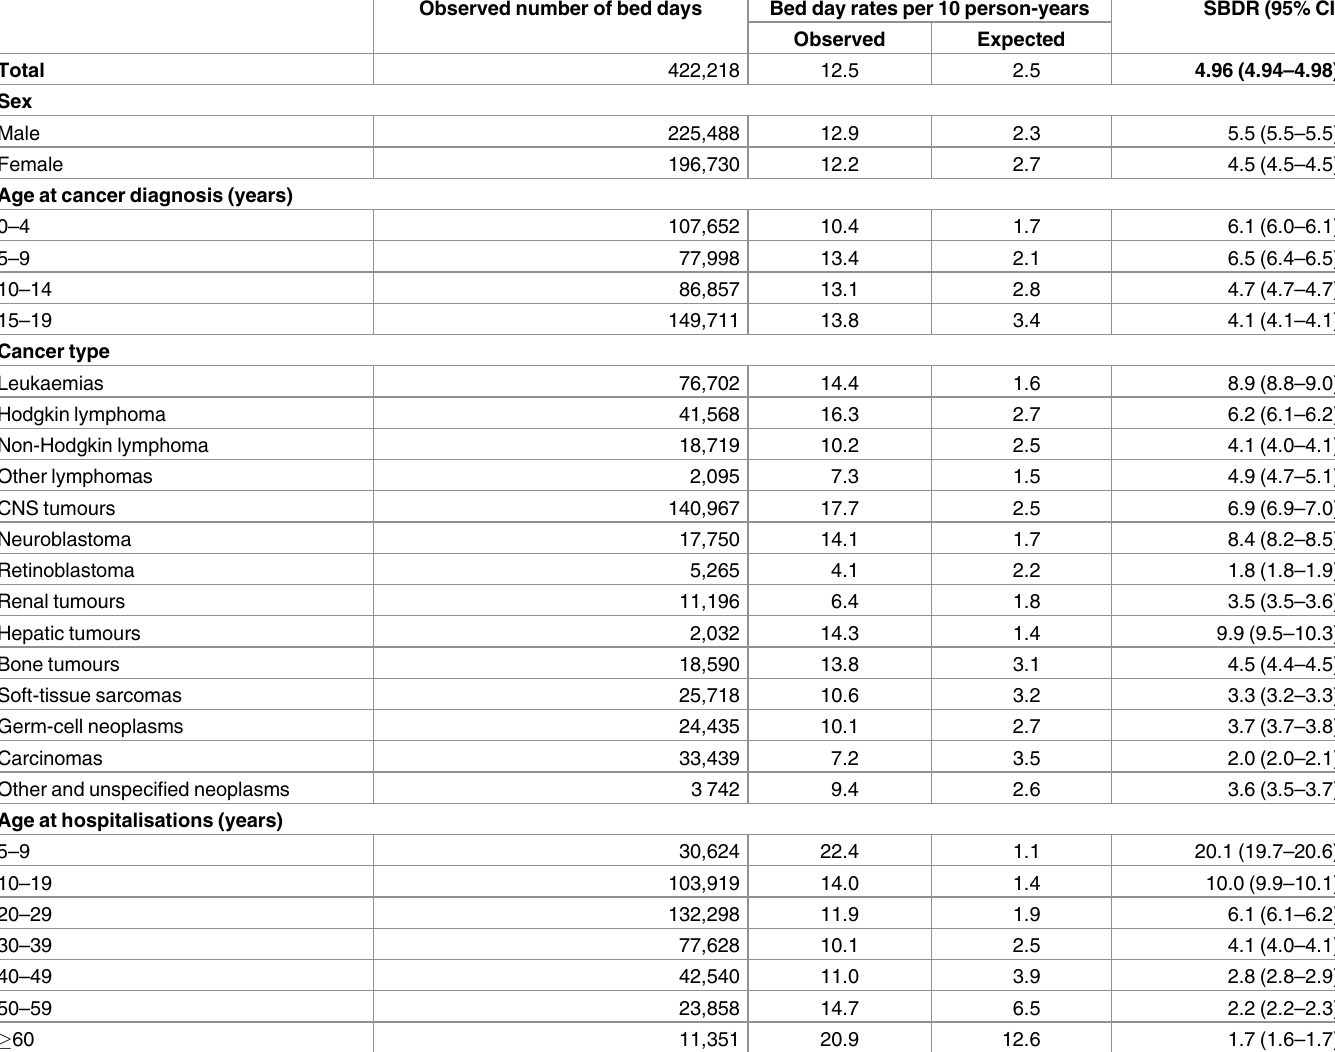
Table 4. Observed and expected numbers of bed days at hospital among 21,297 5-yearsurvivors of childhood cancer and standardised bed day ratios